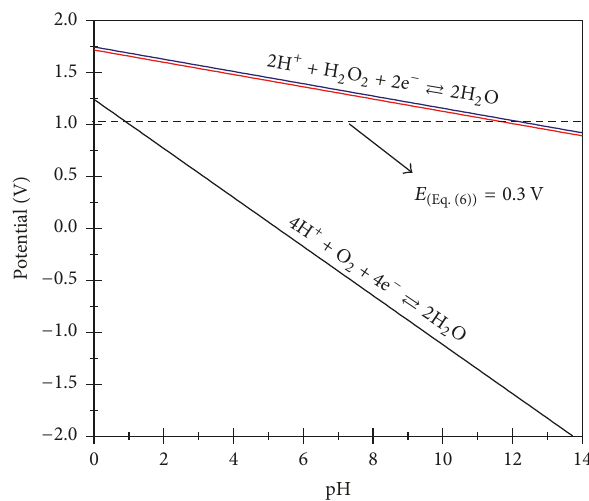
Figure 1: Potential versus pH for O 2 and H 2 O 2 reduction in water [Haynes]. The dotted line (1.02V) represents the limit potential for LiCoO 2 oxidation (delitiation) in water. It was considered that −1 (blue line), and [H 𝑃 = 0.21 atm, [H 2 O 2 ] = 0.10 molL 2 O 2 ] = O 2 0.01 molL −1 (red line).